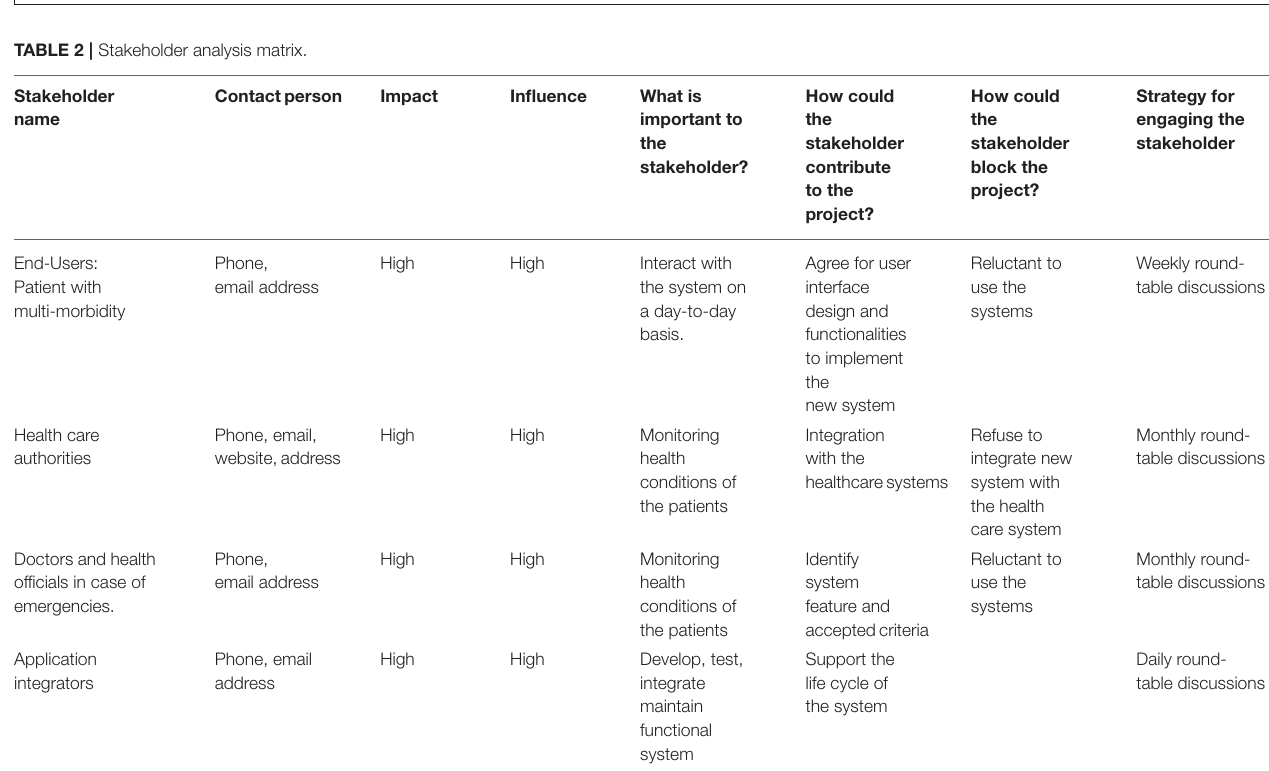
FIGURE 5 | ML application.